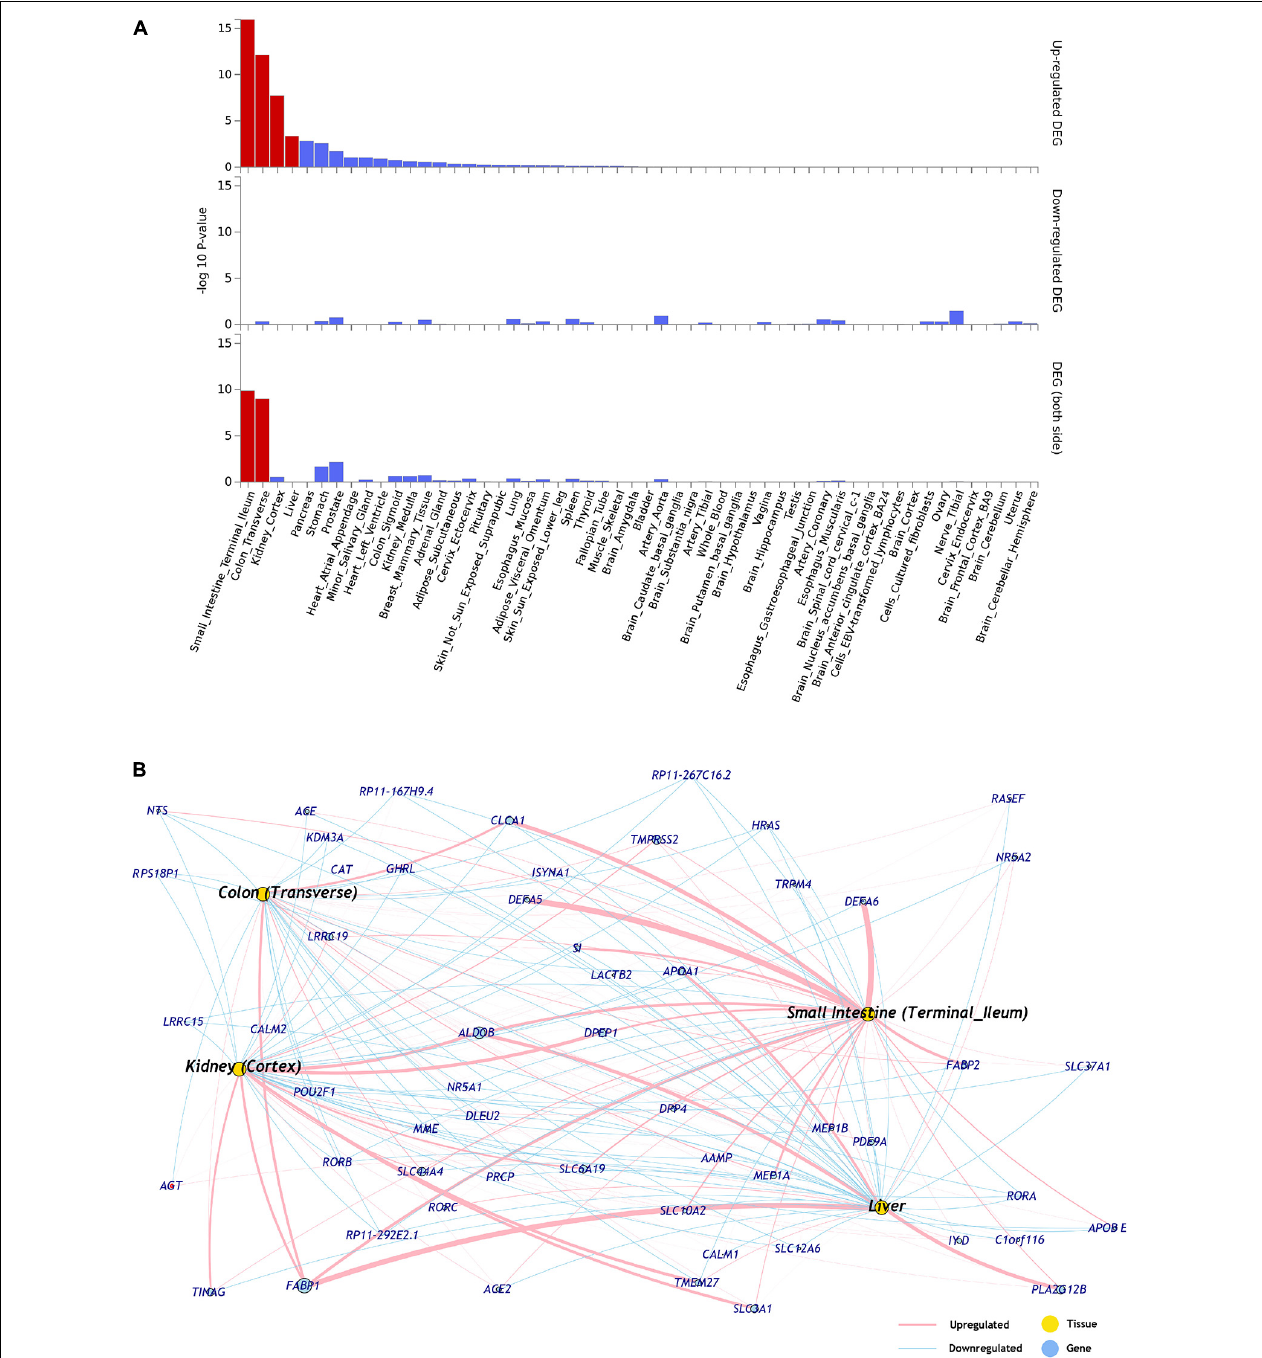
FIGURE 1 | (A) Tissues enriched based on ACE2-network gene expression from GTEx database. The genes from the ACE2-network show over-representation of tissues ( x -axis) and –log10 p -value ( y -axis). The red bars are significant enrichments. (DEG—Differentially expressed genes). (B) The network of genes with tissue specific expression of overrepresented tissues, pink edges represent upregulation and blue edges represent downregulation. The weight of the edges corresponds to expression values (average transcript per million; TPM).